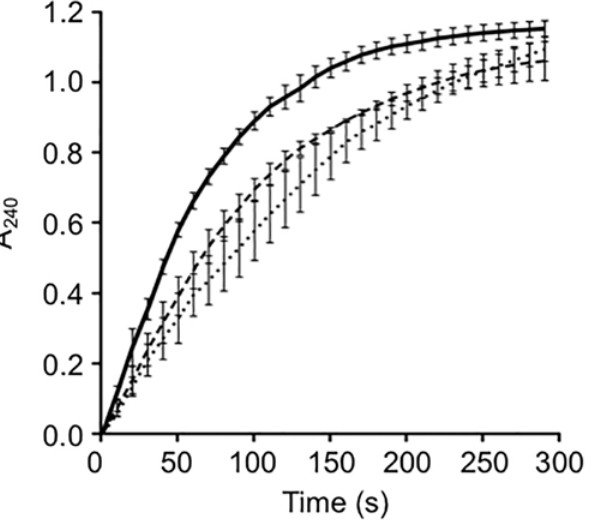
Fig 4. Enzymatic activity of recombinant wild-type SEN and mutant forms. The graph shown was constructed from the averages of three independent experiments, with error bars indicating the standard deviation: wild-type SEN (solid), SEN K312A (dashed) and SEN K362A